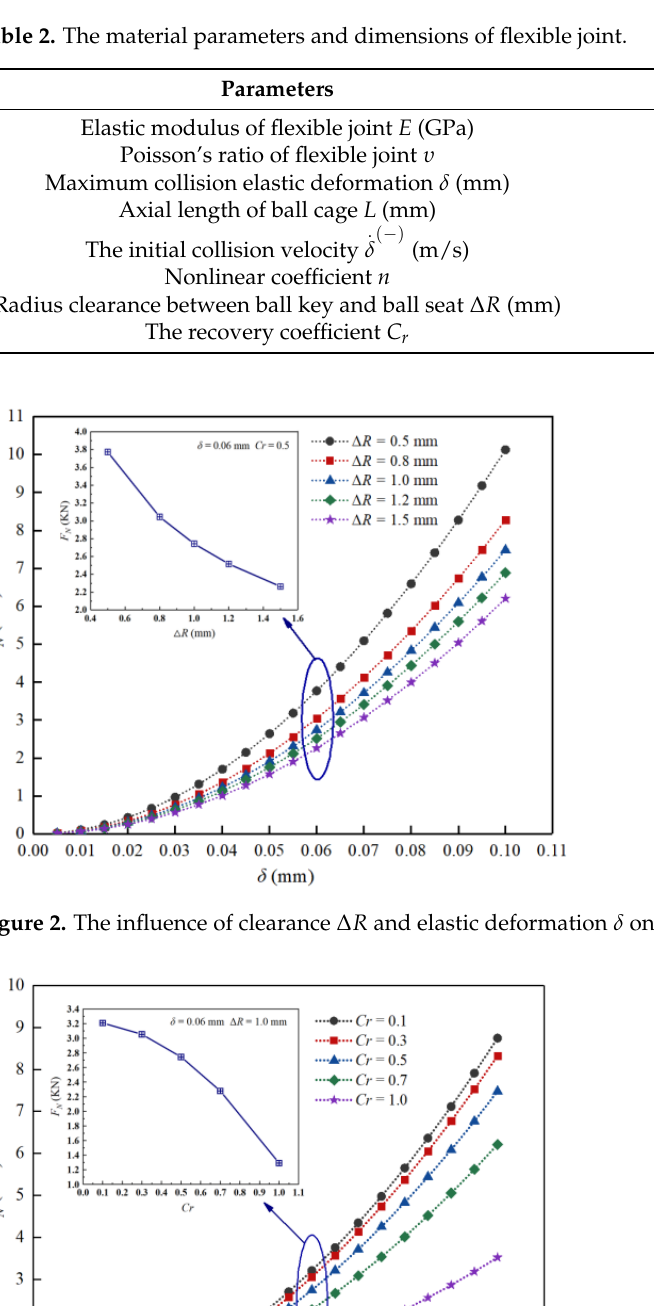
C and elastic deformation δ on the normal contact r